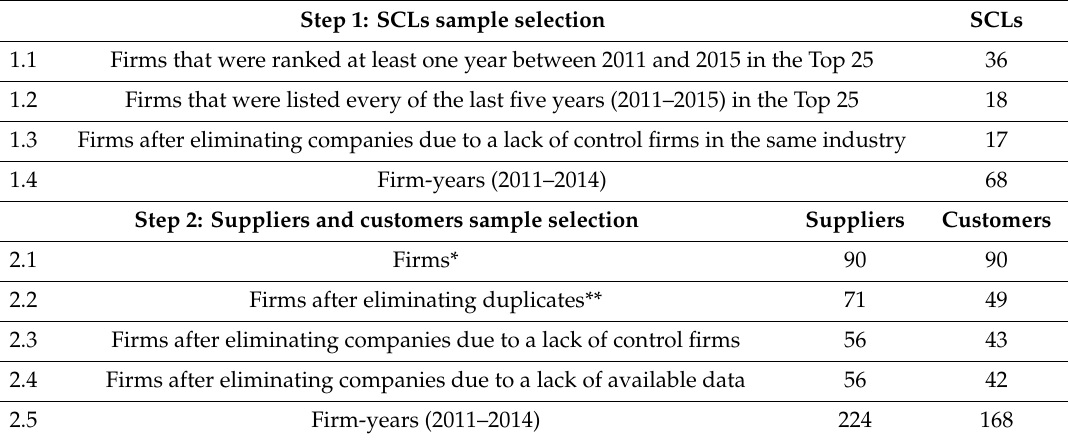
Table 1. Procedure for identifying the firms of the three central samples.